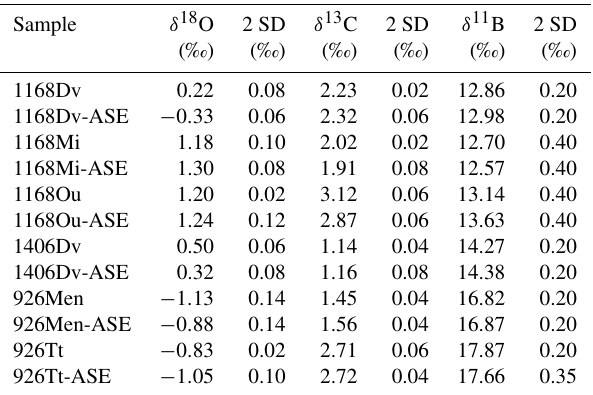
Table 2. δ 18 O, δ 13 C and δ 11 B results for ASE-treated and